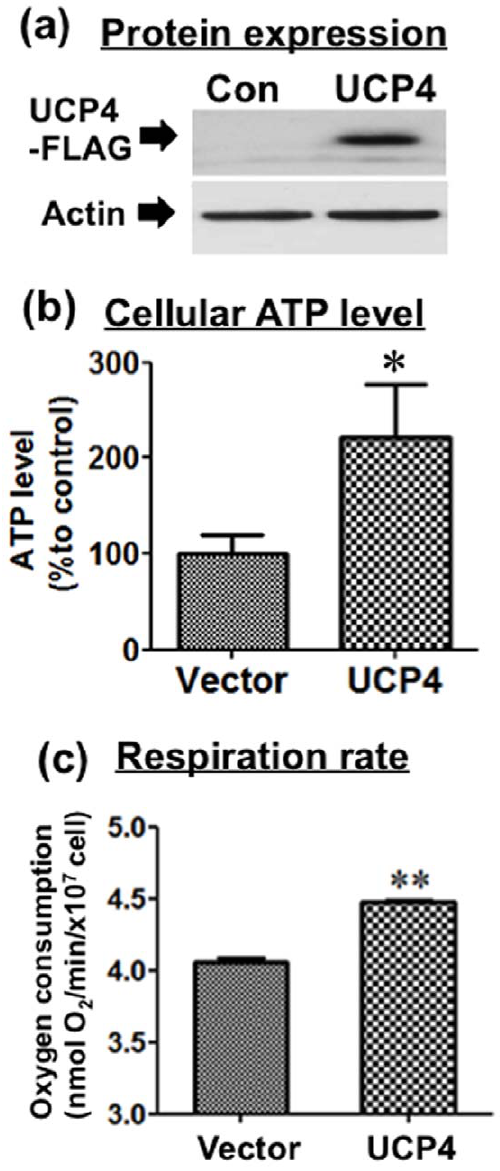
Figure 1. Bioenergetic characterization of SH-SY5Y cells stably overexpressing UCP4. (a) Human UCP4 protein expression level was significantly higher in UCP4-overexpressing cells than vector controls. (b) Total intracellular ATP level in UCP4-overexpressing cells was higher than vector control cells, as determined by luciferase bioluminescent assay in total cell lysates. (c) Rate of respiration in vector control and UCP4-overexpressing cells. Under normal culture condition, oxygen consumption rate of UCP4-overexpressing cells was higher than vector controls. Results are expressed as mean 6 SEM based on at least three independent trials. ** represents statistical significance at p , 0.01, * represents p , 0.05, compared to the vector control cells.